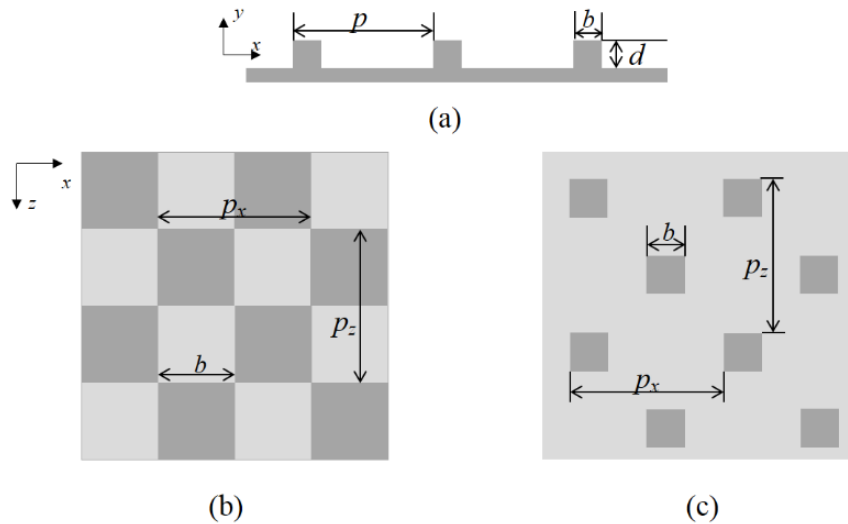
Figure 5. Arrangement of roughness elements on the channel bed: ( a ) 2D square bars, ( b ) 3D cube chessboard arrangements, and ( c ) 3D cube stagger arrangements. Dark squares in ( b , c ) indicate the locations of roughness elements. Flow direction is along the x direction.